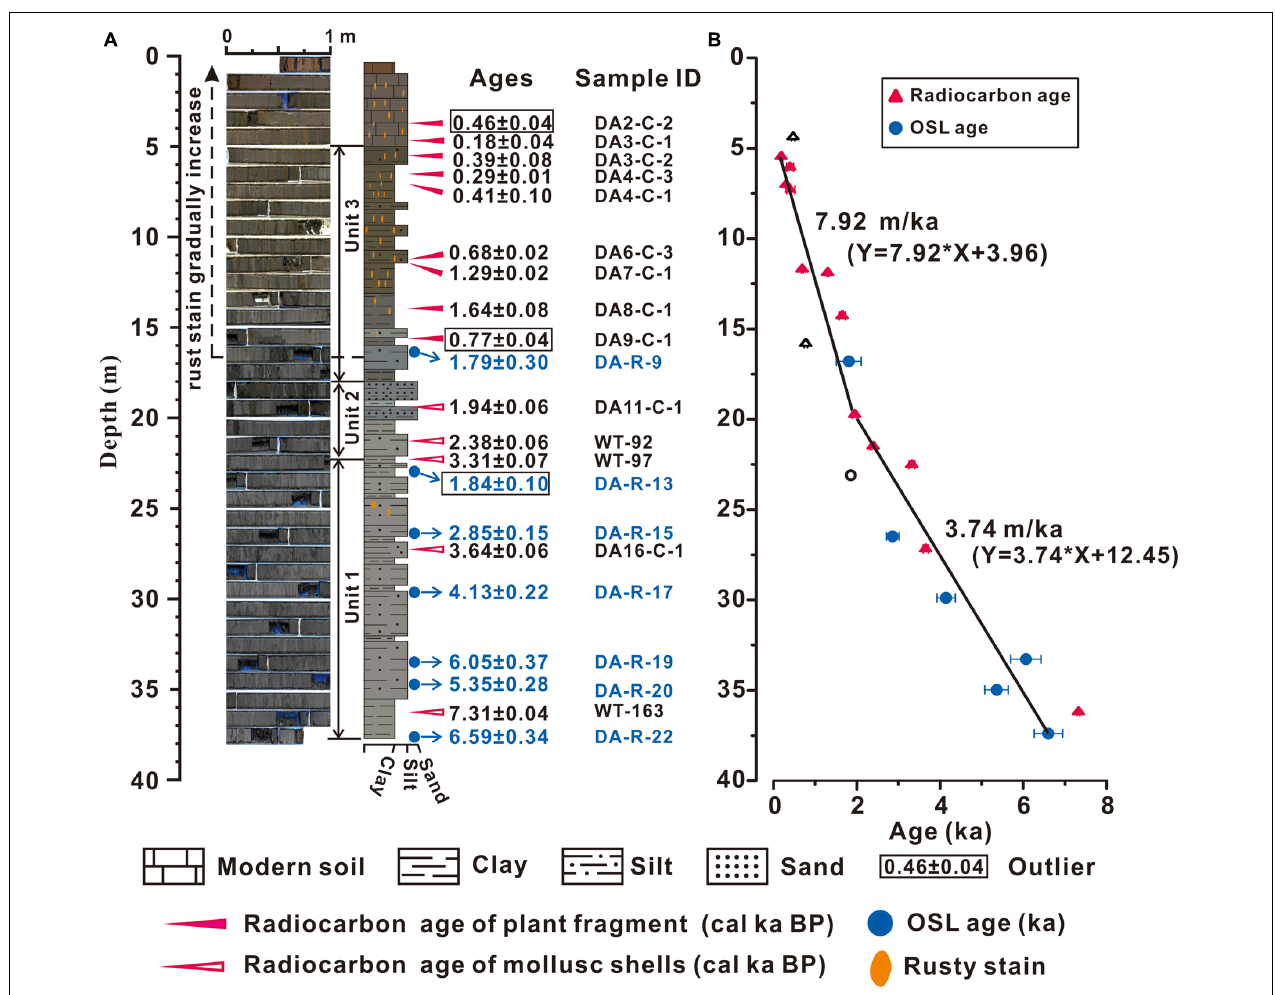
FIGURE 2 | Profile of core DA showing (A) the lithology, OSL and radiocarbon ages; (B) the age-depth model. The color of core profile represents the color observed from field. The hollow triangle and circle in (B) represent the outlier age of 14 C and OSL,